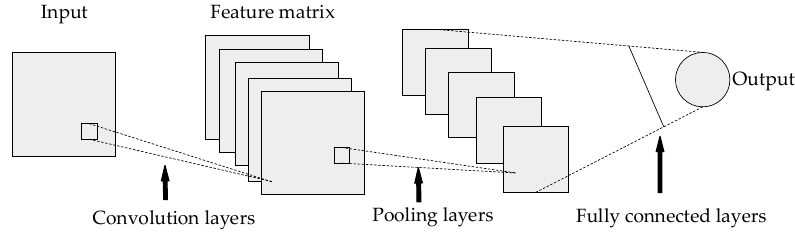
Figure 8. CNN overall structure.